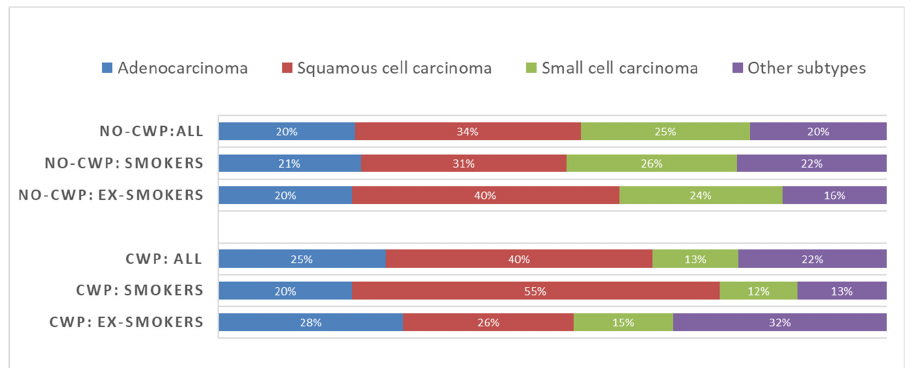
Figure 3. Comparison of histopathological findings of lung cancer in the cohorts of miners according to the presence of coal-workers´ pneumoconiosis (CWP) and smoking status (No-CWP—miners without CWP, CWP—miners with CWP); note that non-smokers were omitted from this figure due to their very small representation in both cohorts (see Table 3).